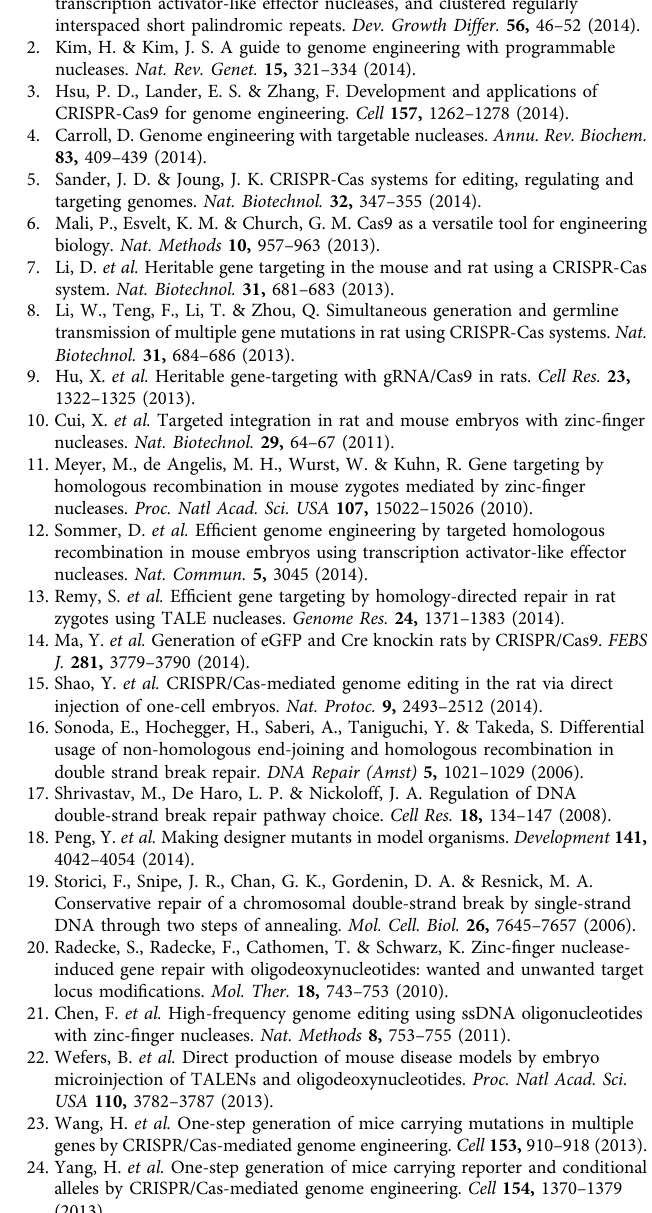
Supplementary Table 6. ssODNs were obtained from Integrated DNA Technologies. pCAGGS was obtained from RIKEN BRC, which is participating in the National Bio-Resource Project of the Ministry of Education, Culture, Sports, Science and